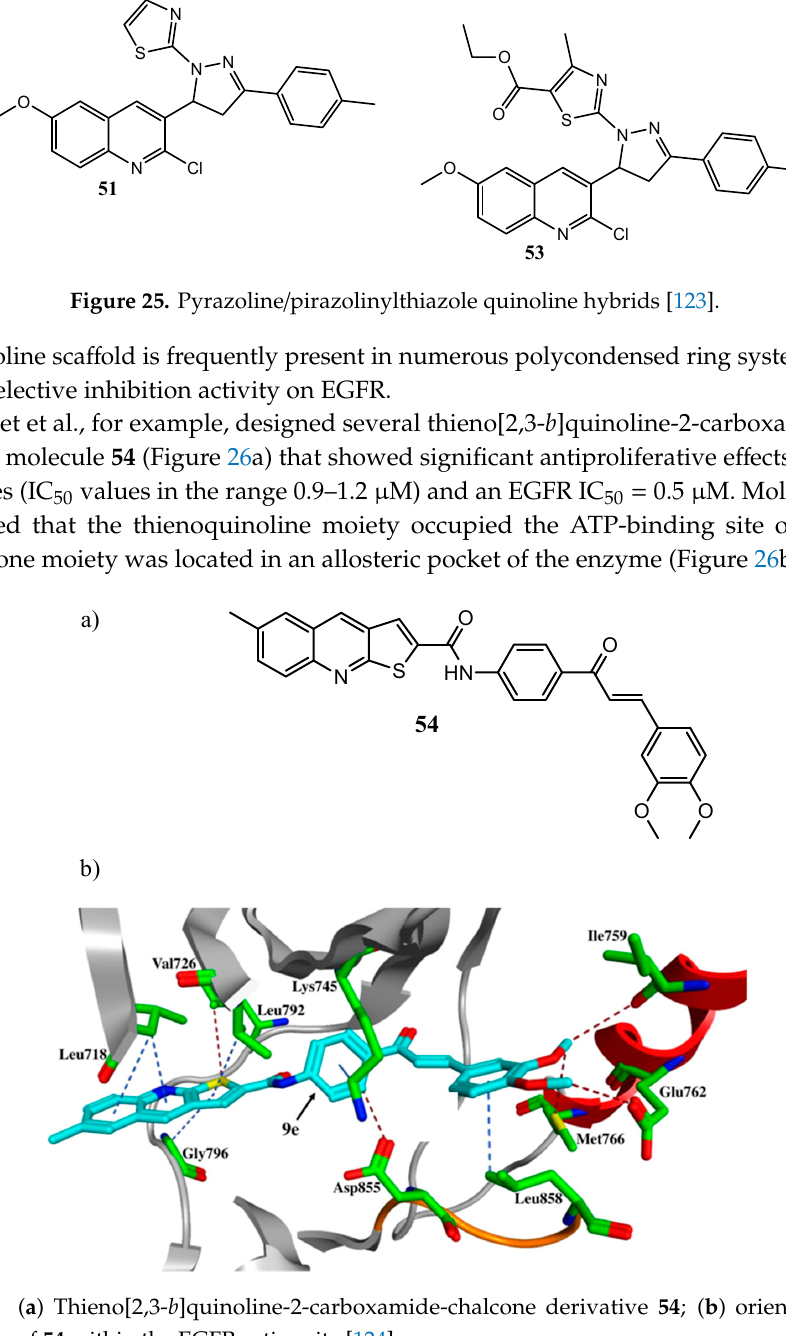
Figure 27. Structure of benzo[ h ]quinoline derivative [125].